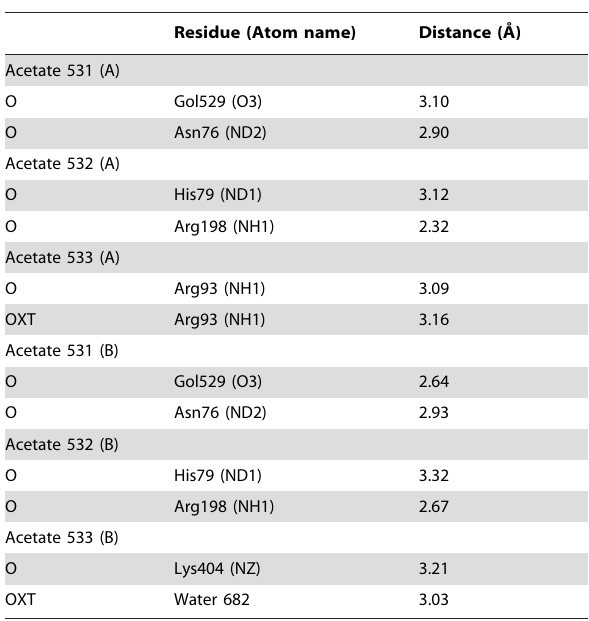
Table 2. Contacts for acetate